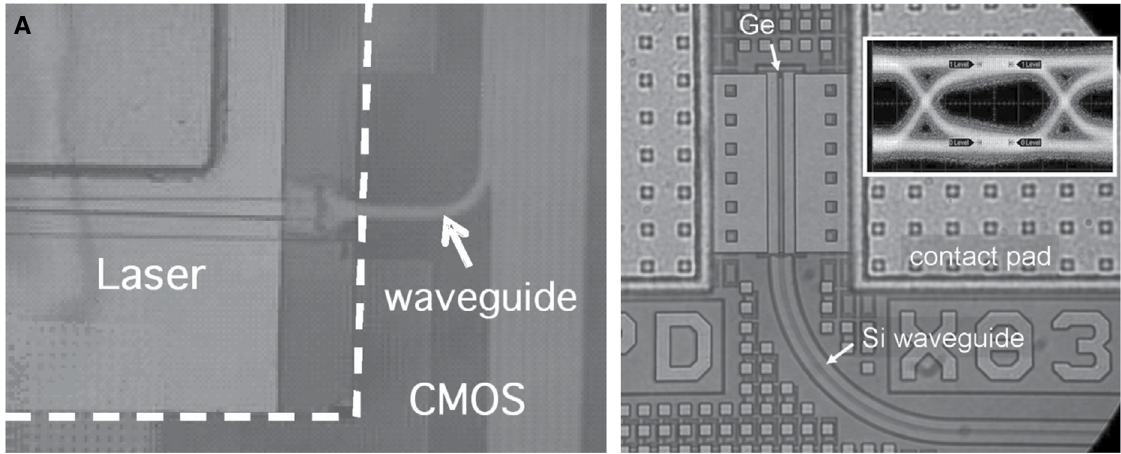
Figure 3 Images of optoelectronic chips produced by Luxtera Corporation and how (A) III–V lasers and (B) Ge photodetectros are integrated with Si waveguides